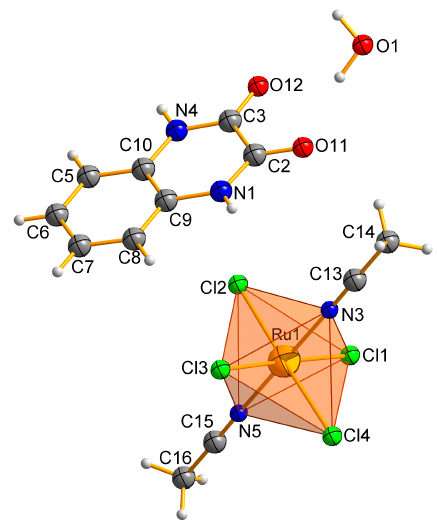
Figure 3. Molecular structure with the atom numbering scheme and coordination polyhedron of complex 2 .